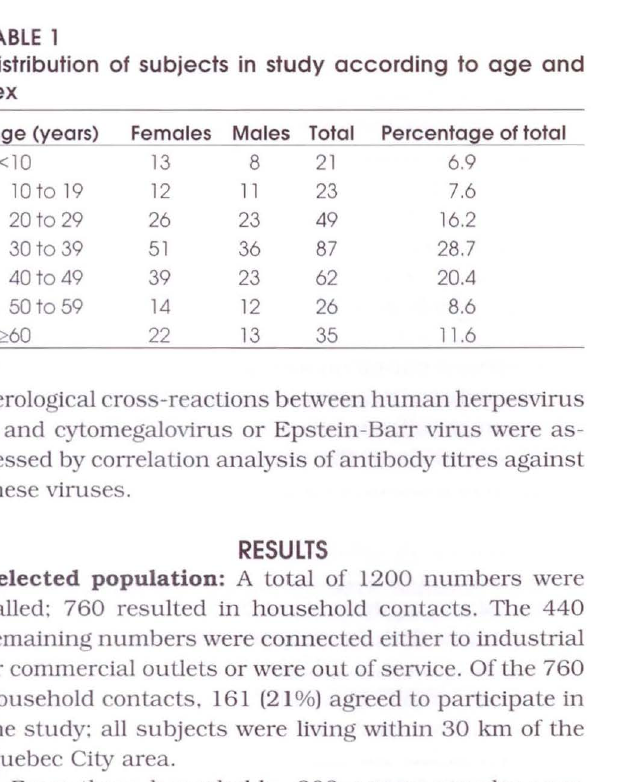
age (linear regression P=0.05) (Fi ure 1). To ex-plain